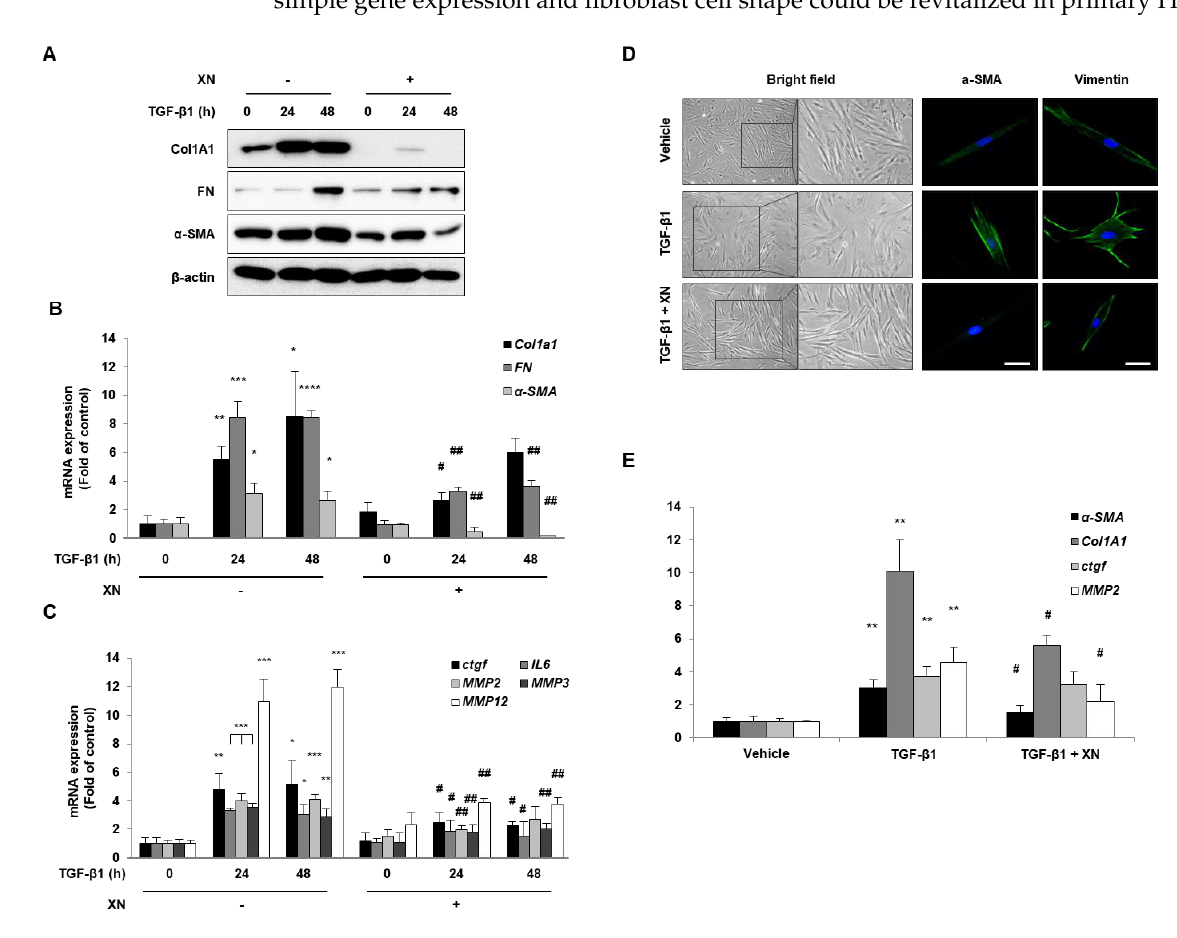
Figure 1. Inhibitory effects of the XN for intestinal fibrosis in primary HIFs. ( A ) Protein levels of Col1a1, FN, and α -SMA were measured by immunoblotting. ( B ) The mRNA levels of Col1a1 , FN, and α -SMA were assayed by qRT-PCR. ( C ) The mRNA levels of Ctgf , IL-6 , MMP2 , 3 , and 12 were determined by qRT-PCR. For (B) and (C), data are means ± SD for three separate experimental samples. Data were analyzed by Tukey’s test (**** p < 0.0001, *** p < 0.001, ** p < 0.01, * p < 0.05 vs. vehicle cells; ## p < 0.01, # p < 0.05 vs. TGF- β 1-treated cells). ( D ) Primary HIFs were exposed to TGF- β 1 for 24 h and then the supernatant was discarded, and the cells were incubated further for 24 h with vehicle, TGF- β 1, or TGF- β 1 combined with XN, respectively. After the experiment, we observed cell morphology (bright field) using a microscope (magnification: × 40) and endogenous expression of α -SMA and vimentin (green), respectively. Images were examined on a confocal microscope. Scale bar: 40 µ M. ( E ) The Col1a1 , α -SMA , MMP2, and Ctgf mRNA levels were determined by qRT-PCR. D ata are means ± SD for three separate experimental samples. Data were analyzed by Tukey’s test (** p < 0.01 vs. vehicle cells; # p < 0.05 vs. TGF- β1 -treated cells).